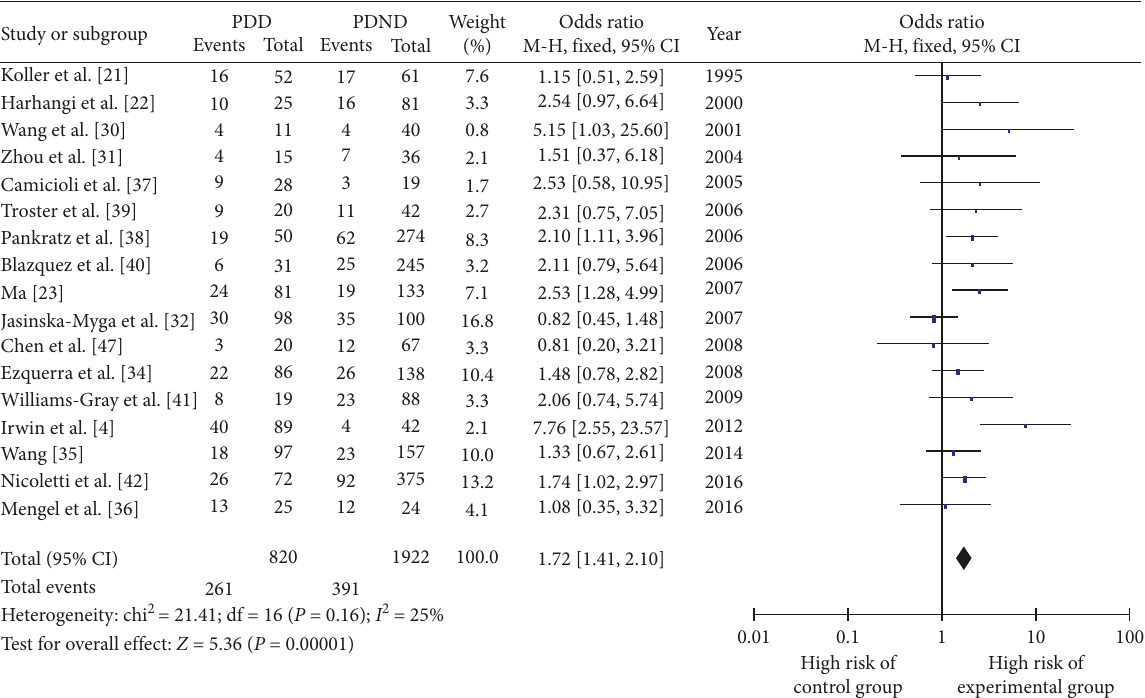
patients assessed in 17 studies. −